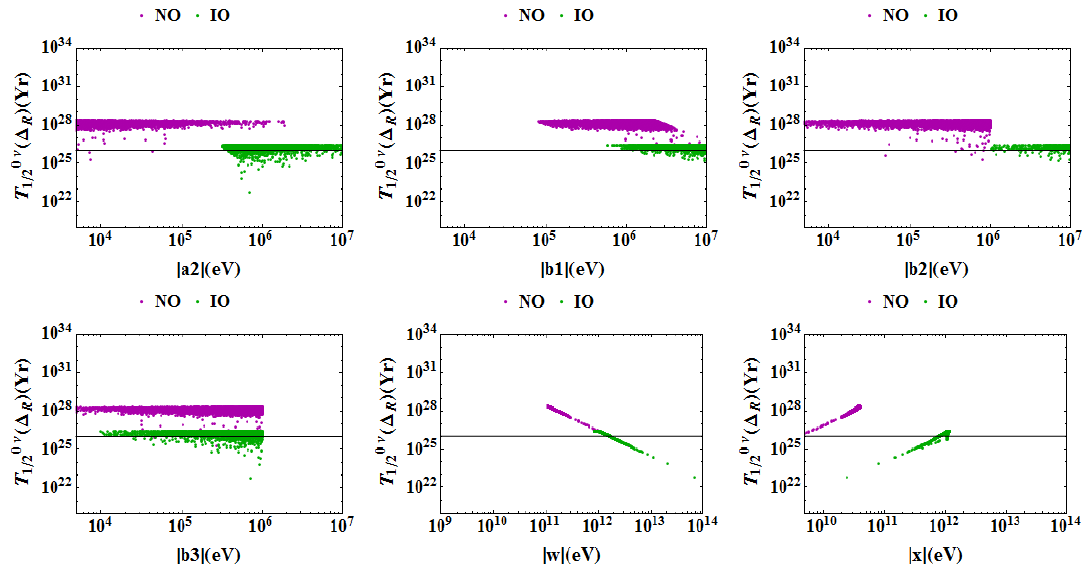
the class B4. The horizontal line represents the KamLAND-Zen lower limit.